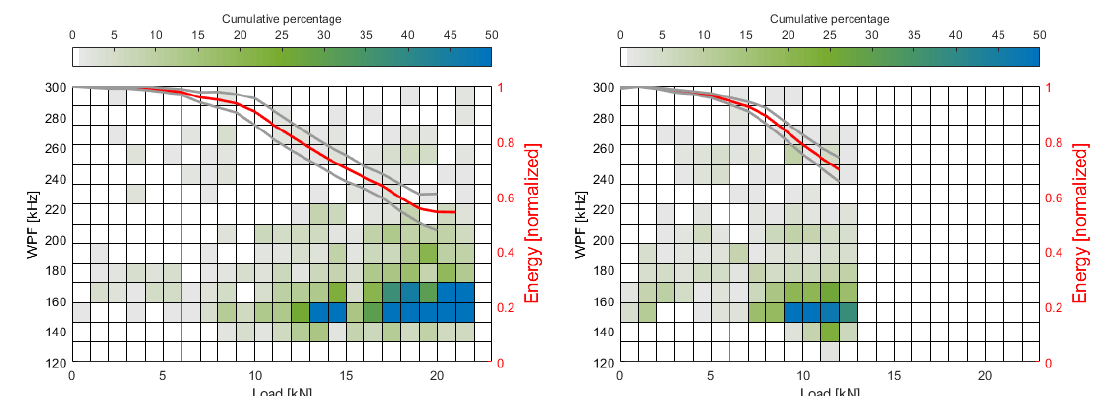
Figure 7. Mean value (red) and standard deviation (gray) of the energy of the evaluated wave package. Color-coded is the cumulative percentage of the WPF in a frequency band for each load level. Left : 0/90 test specimen 2–20. Right : +45/ − 45 test specimen